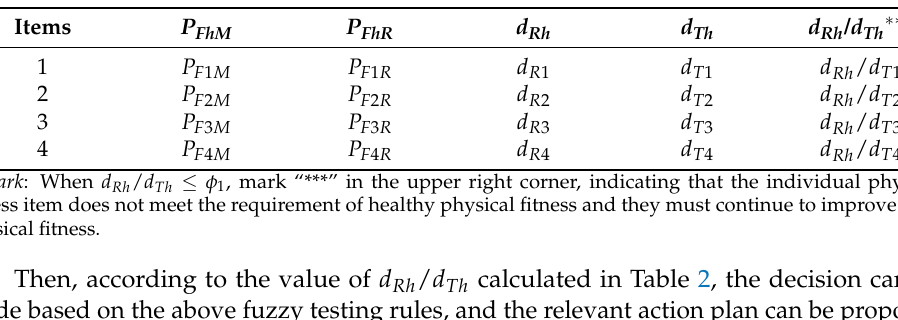
Table 2. Fuzzy evaluation table for physical